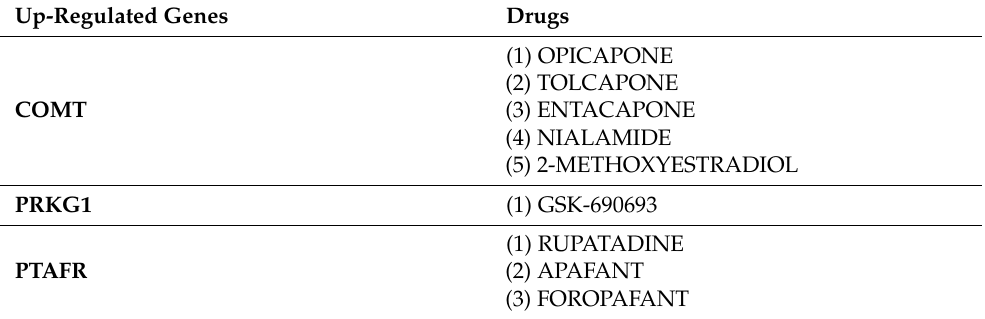
Table 2. Up-regulated genes and their interactions with known drugs in at least two of three drug databases (DGIdb, DrugCentral, and The Drug Repurposing